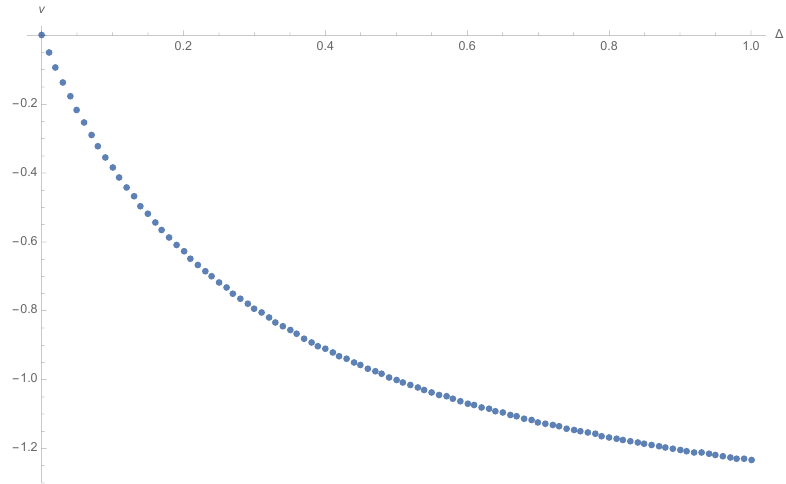
Figure 9. The deflection of the null ray at v = 0 plotted as a function of the operator weight of the deforming operator ψ . Notice that the deflection is negative, indicating the geometry has become traversable. The deflection vanishes for ∆ = 0 , which corresponds to taking ψ to be the identity. The vertical scale is measured in units of 1 / 16 πG N